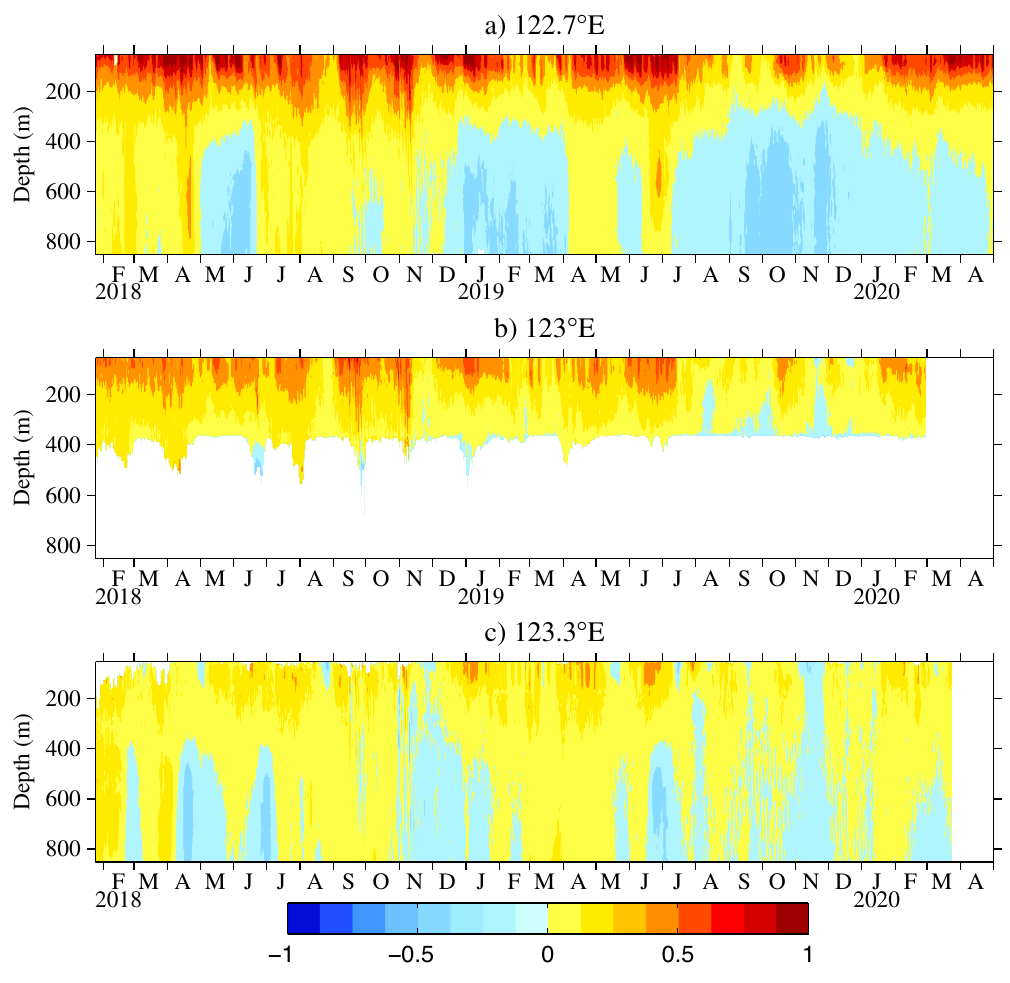
Figure 3. Daily meridional velocities from ADCPs at ( a ) 122.7° E (January 2018 to May 2020), ( b ) 123° E (January 2018 to February 2020), and ( c ) 123.3° E (January 2018 to March 2020) along 18° N (units are m/s). Figures are plotted using MATLAB R2012b (http:// www. mathw orks.